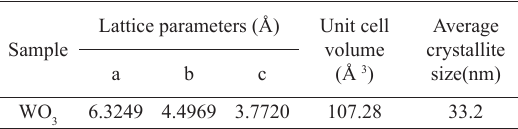
Figure 3. XRD patterns of WO Table 2. Lattice parameters, unit cell volume and average grain size of